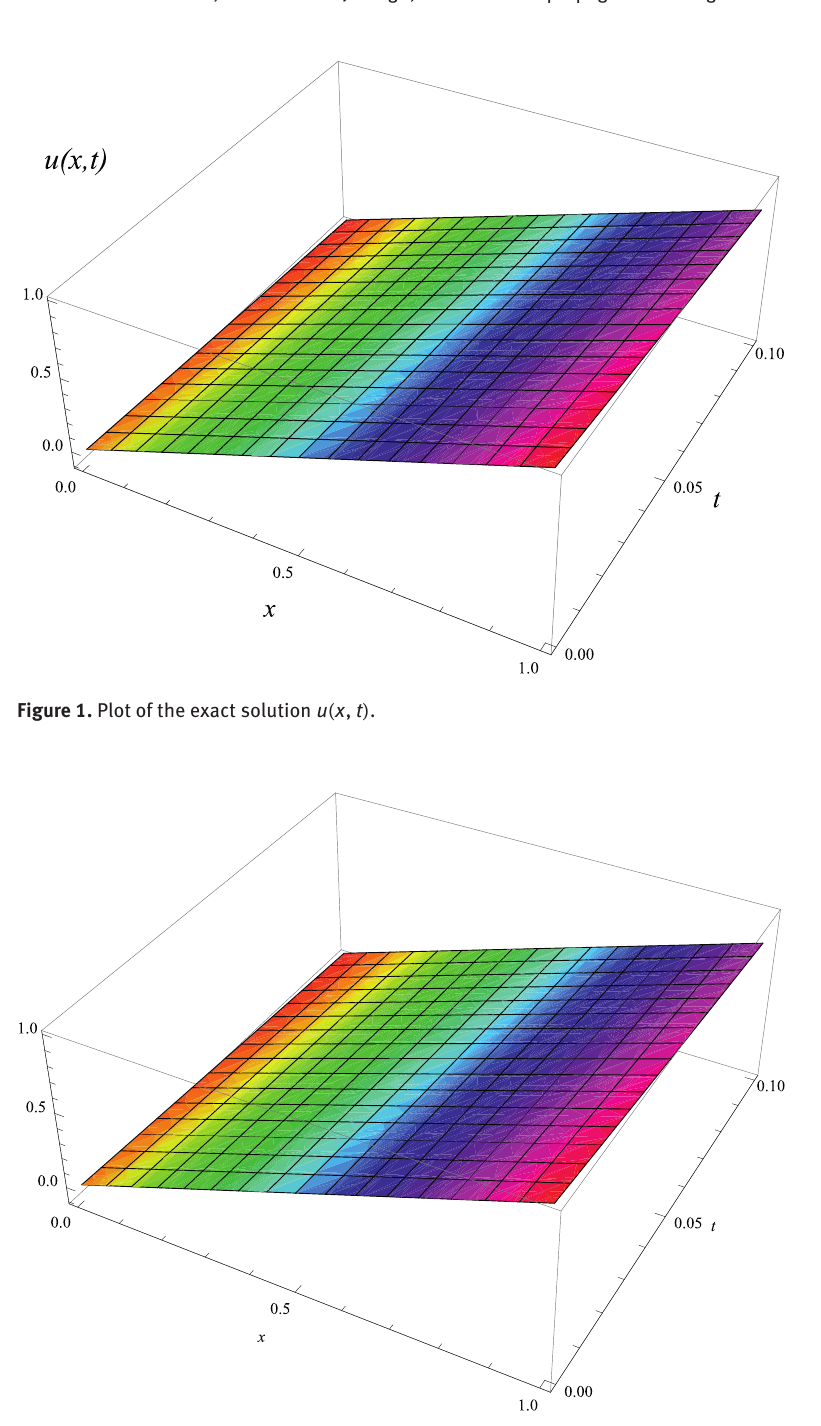
Figure 2. Plot of the approximate solution obtained by new HATM at the level n =